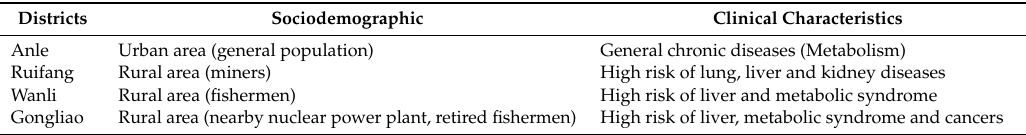
Table 1. Sociodemographic and clinical characteristics of the